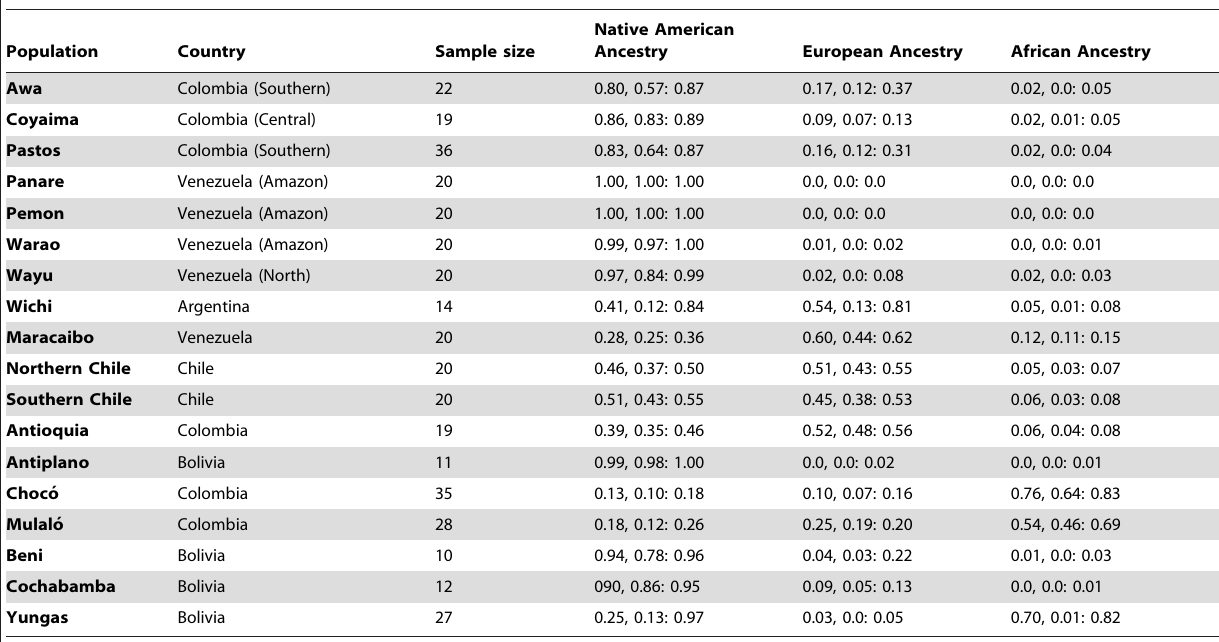
Table 4. Ancestry of Latin American